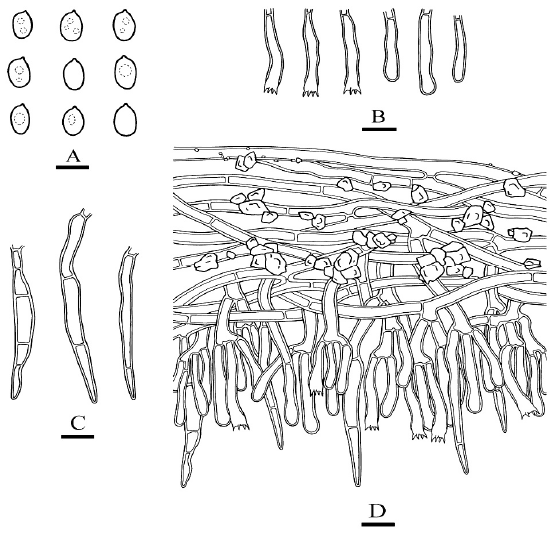
Figure 6. Microscopic structures of Phanerochaete rhizomorpha (holotype): basidiospores ( A ), basidia and basidioles ( B ), cystidia ( C ). A section of hymenium ( D ). Bars: ( A ) = 5 µm, ( B – D ) = 10 µm.